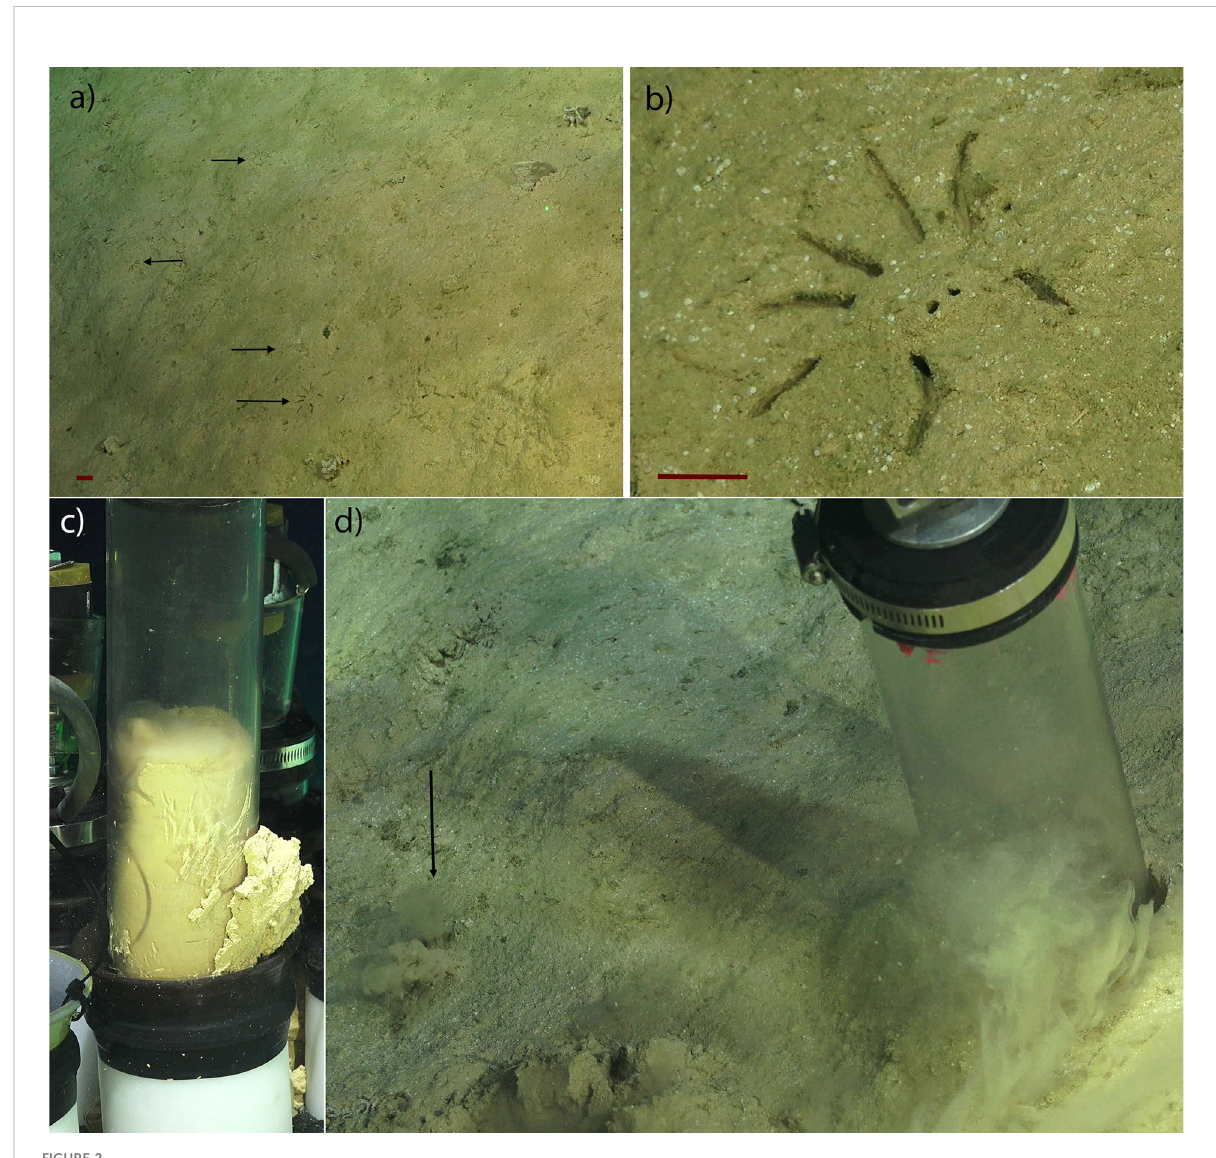
FIGURE 2 Spider traces observed from the western Australian margin (3886 m depth) with (A) ROV camera zoomed out with horizontal arrows showing spider traces, (B) ROV camera zoomed in, (C) pushcore showing possible tendrils extending into sediment, and (D) deployed pushcore with vertical arrow showing sediment plume. Red scale bars represent 100